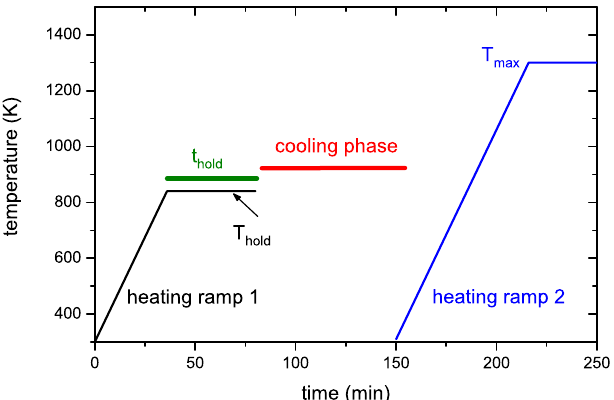
Figure 3. Schematic plot of the heating scheme for the ramp and hold experiments (detailed description see Section